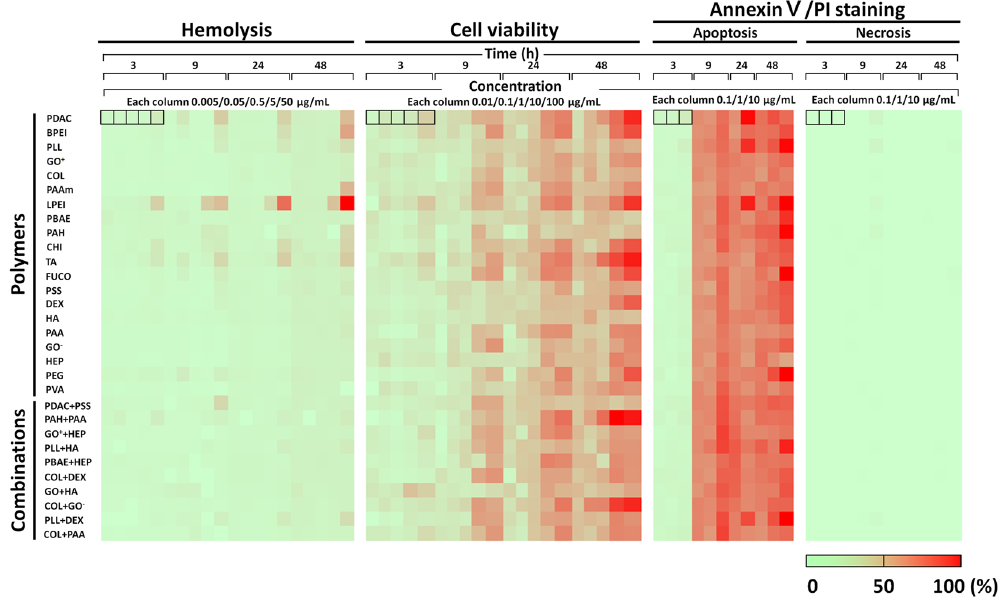
Figure 2. Heat map indicating the cytotoxic effects of whole materials according to concentration and time. The colors indicate the relative cytotoxicity levels (percentages of hemolysis, cell death, and apoptotic or necrotic cells) for each polymer and combination under 64 different conditions in the rows (all polymers and combinations of three/five doses × four culture times × three assays).